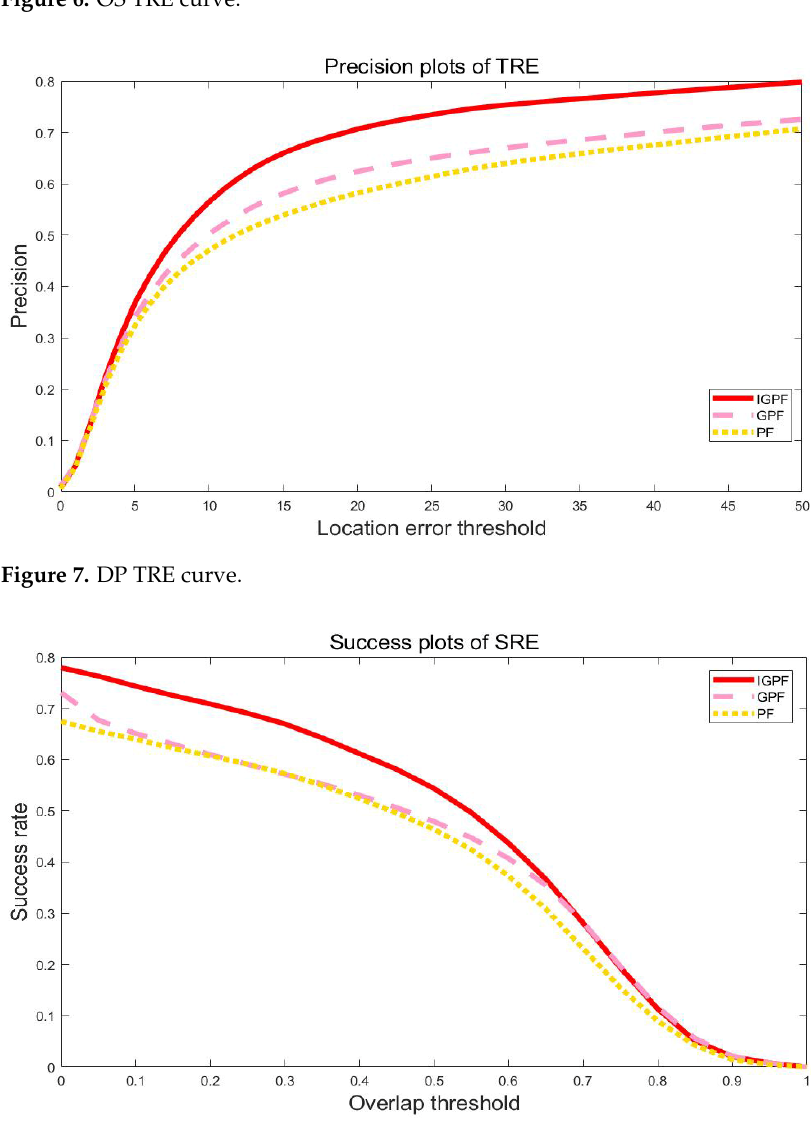
Figure 9. DP SRE curve.